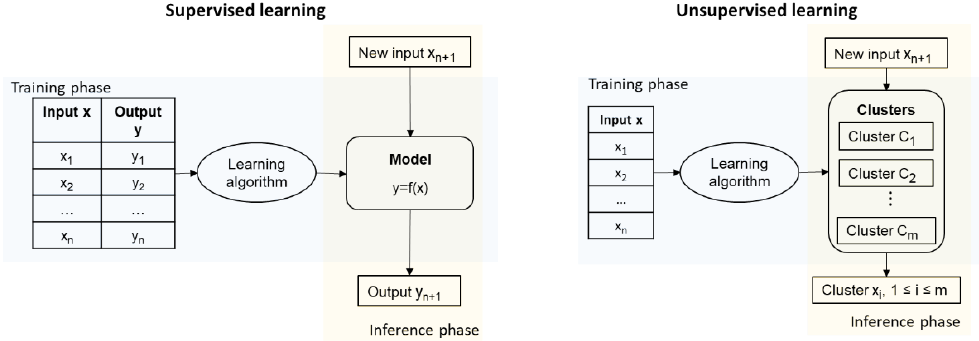
Figure 1. Supervised and unsupervised learning approaches.